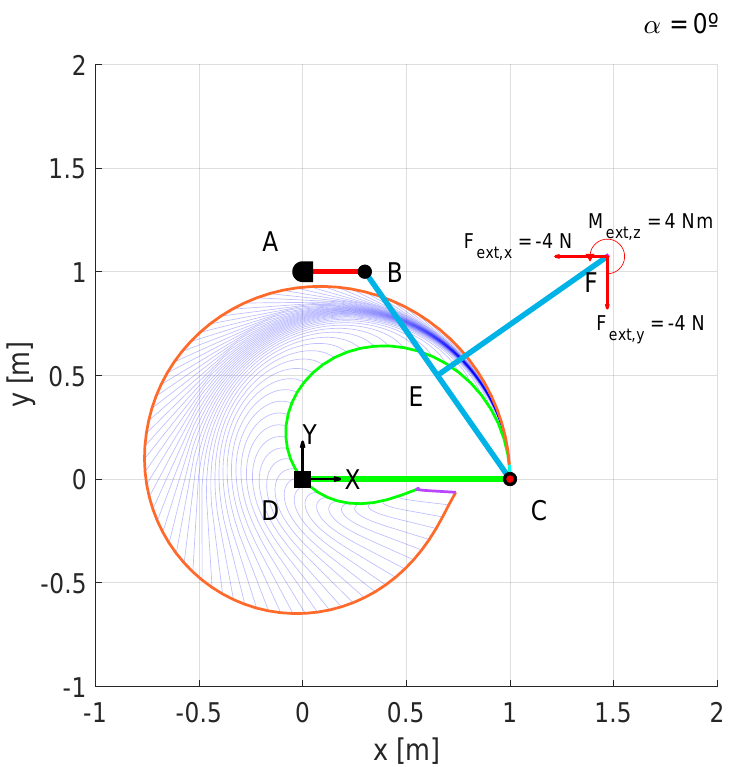
Figure 17. First mechanism circuit under external loading of F ext , x = − 4 N, F ext , y = − 4 N, and M ext , z = 4 Nm. Initial position.